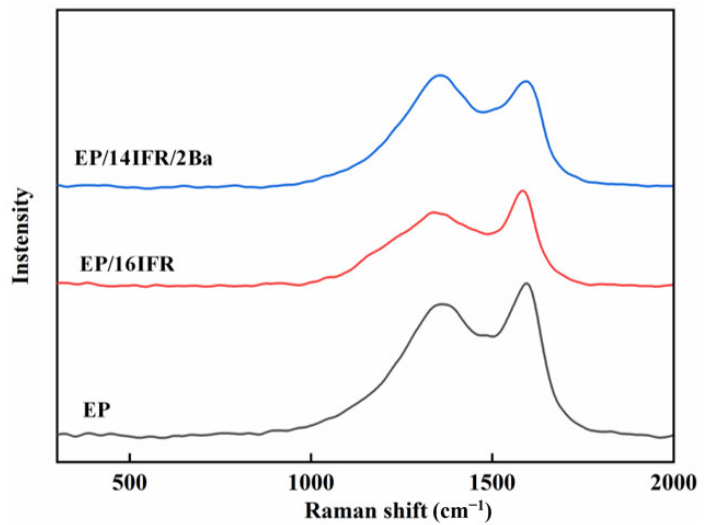
Figure 10. Raman spectra of EP, EP/16IFR and EP/14IFR/2Ba after combustion.